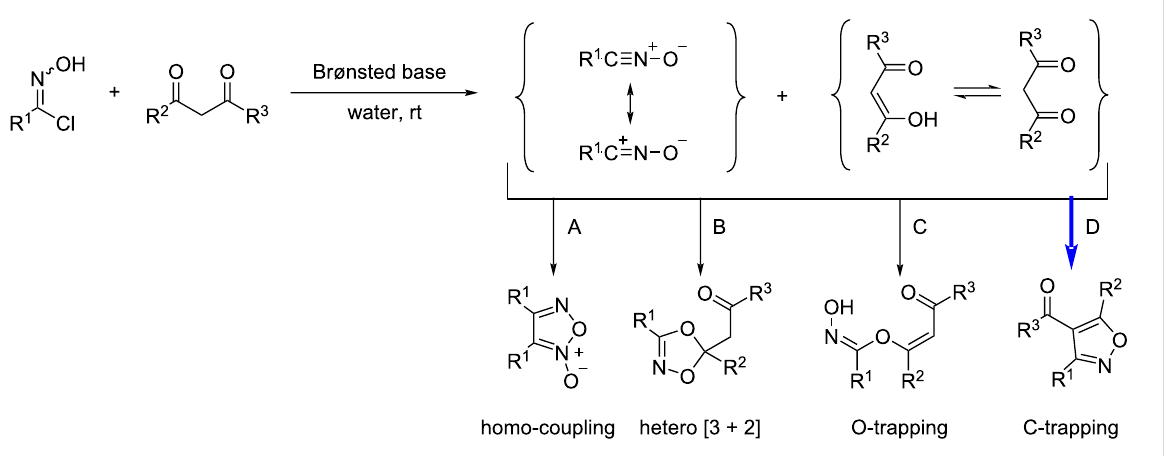
Figure 2: Possible products of the reaction between nitrile oxides and 1,3-diketones. Path D (C-trapping) produces 3,4,5-trisubstituted isoxazoles.